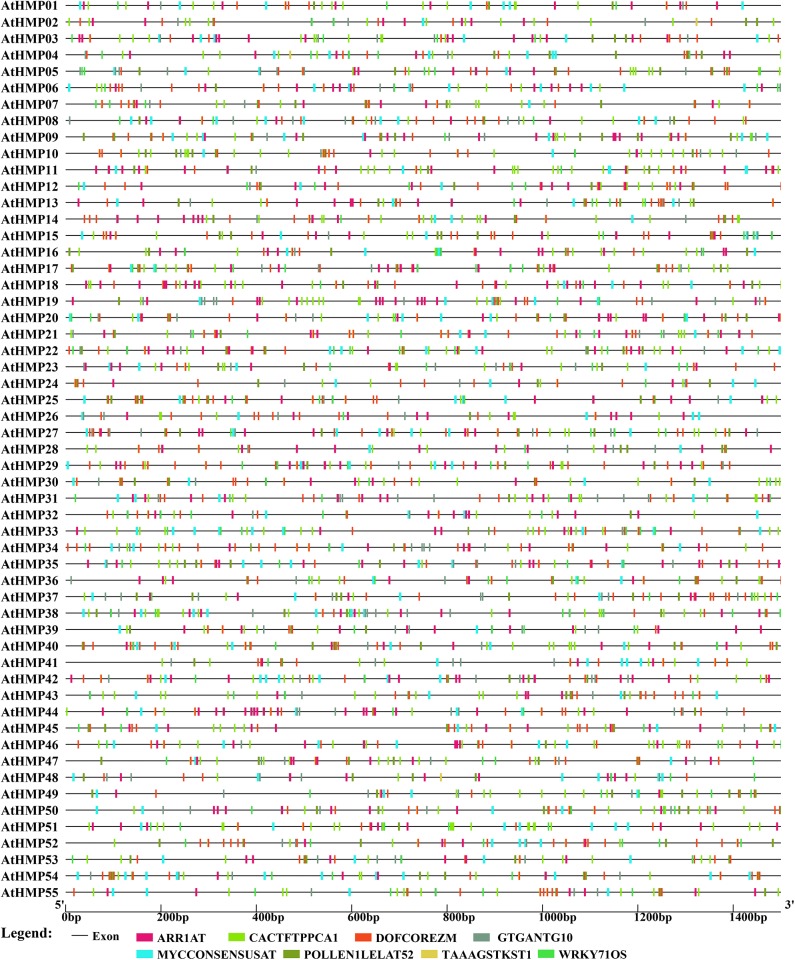
Predicted cis-elements in the promoter regions of the Arabidopsis heavy-metal-associated genes. All promoter sequences (−1,500 bp upstream genomic sequence) were analyzed. The heavy-metal-associated genes are shown on the left side of the figure. The scale bar at the bottom indicates the length of promoter sequence. Different cis-elements were labeled by rectangle of different color.